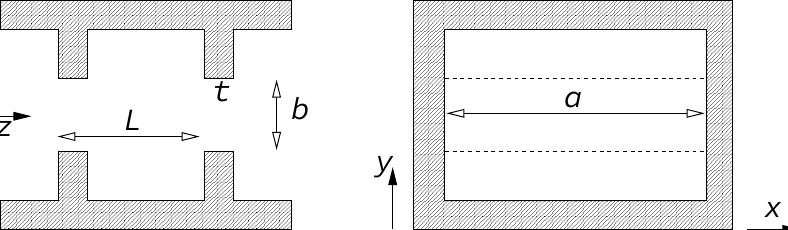
FIG. 1. Relevant geometry.